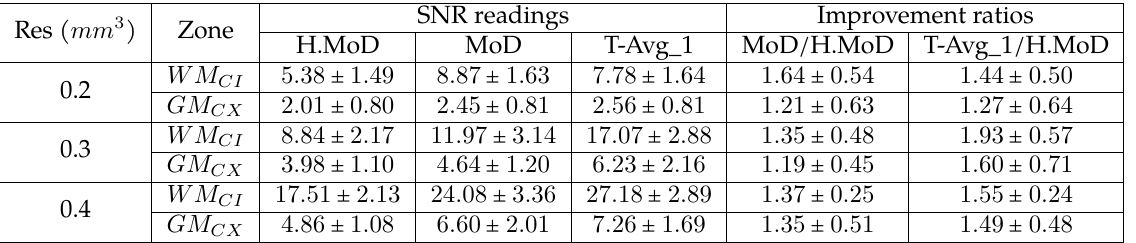
Table 4: FA-SNR for the H.MoD (one machine average), MoD (three machine averages), and T-Avg_1 (our procedure) in gray and white matter. The ratios show the difference in performance between the scanner averaging function and method depicted in Figure 2. The treated data (T-Avg_1), and the MoD use the same scanning time, providing a fair comparison scheme. Res: Resolution, WM : White matter (Internal Capsule), GM : Gray matter (Cortex). The arrows on CI CX the right show whether our method behaved